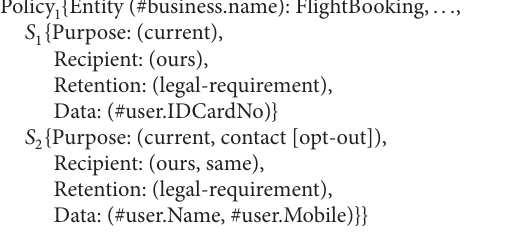
Algorithm 7: P3P policies of FlightBooking service, HotelReser- vation service, and Payment service (P3P policy of FlightBooking service).